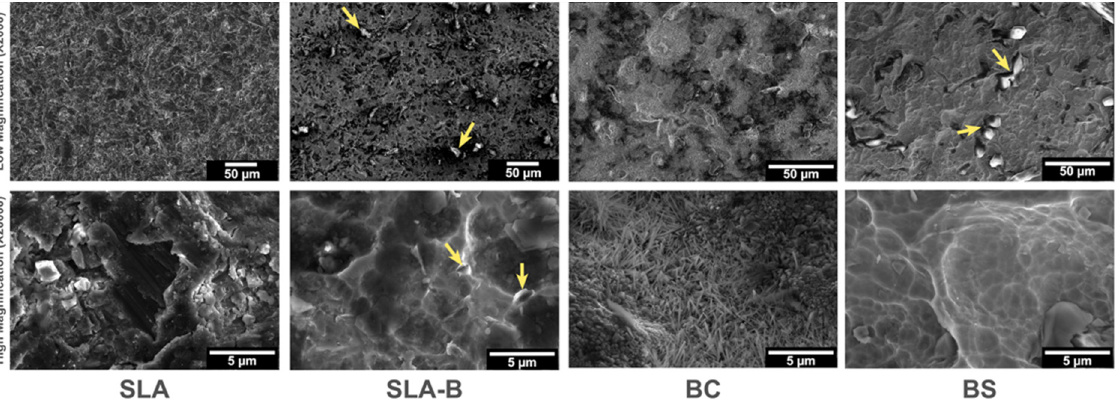
Figure 3. Scanning electron microscope images of the experimental surfaces. SLA surface revealed the typically known topographical features. Remnants of H 3 BO 3 particles (arrows) were observed on the SLA-B (low magnification; ×2000). Nanowire-shaped crystallized B areas (high magnification; ×20,000) were visible on the BC surface due to the coating process at high temperatures. The BS surface was found to have nonuniformly distributed H 3 BO 3 particles leftover from the H 3 BO 3 solution (arrows). The region with H 3 BO 3 particles indicated by arrows is also shown at higher magnification.